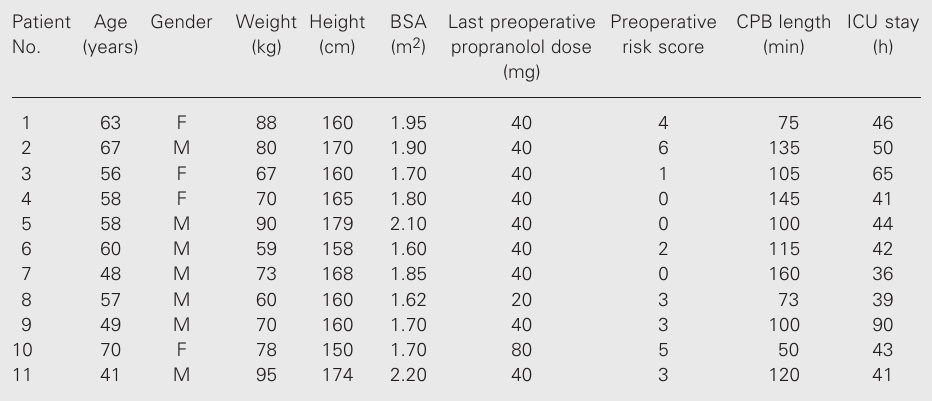
Table 1. Characteristics of the